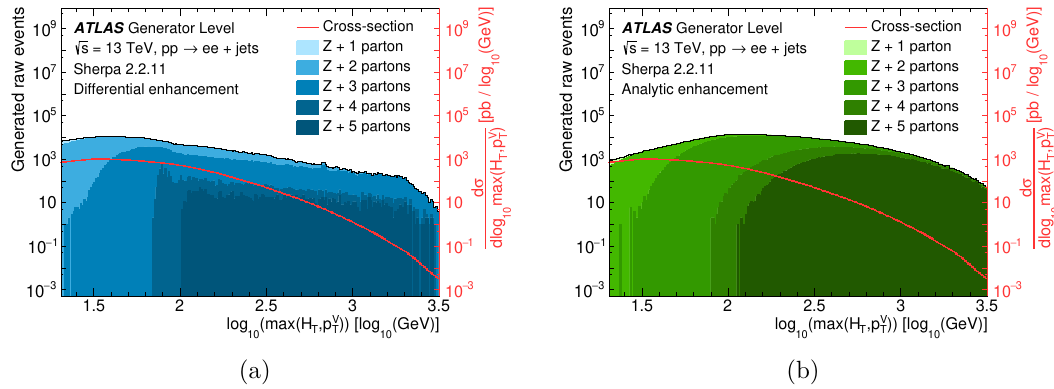
Figure 11 . Distribution of unweighted MC sampled events for the Sherpa configurations with (a) differential and (b) analytic enhancement as a function of log ( max ( H )) . The differential , p V T T 10 enhancement is specified using log ( max ( H )) function, while the analytical enhancement uses , p V T T 10 the ( max ( H ) / 20) 2 function. In (b) the Z +1 parton contribution is small and only visible in , p V T T the top left of the